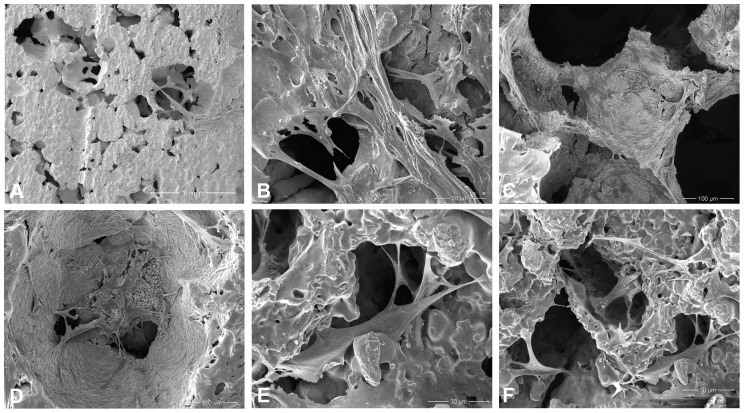
Scanning Electron microscopy of cells co-cultured with alloy specimens at different time point.(A) After the cells had been inoculated for 3 hours, rabbit bone marrow mesenchymal stem cells which were regular elongated-spindly shaped adhered to the surface of the alloy with 70% porosity. (B) After 24 hours, pseudopodia-like protrusions of the cells appeared, interrelated between each other with the cells tightly attached to the surface of the alloy with 70% porosity. (C–D) After 72 hours inoculated, cells began growing to the inside pores of the alloys with 70% porosity (C) and 40% porosity (D). (E–F) The cells were growing from the edge to inside of pores of the 70% porosity group in which extracellular matrix also could be seen.